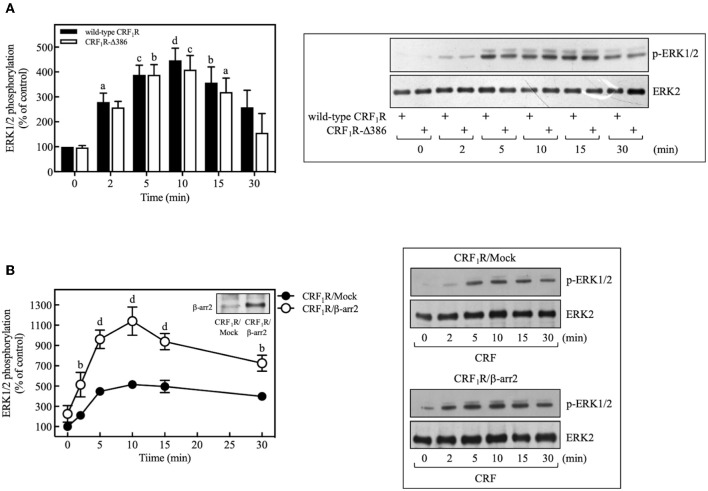
β-arrestin does not participate in the CRF-stimulated ERK 1/2 phosphorylation in COS-7 cells. (A) COS-7 cells expressing HA-CRF1R (wild-type CRF1R) or HA-CRF1R-Δ386 mutant were stimulated with 100 nM CRF for the indicated times. (B) COS-7 cells co-transfected with a β-arrestin-2 (β-arr2) expression vector or an empty control vector (Mock) and the pcDNA3-HA-CRF1R expression vector were stimulated with 100 nM CRF for the indicated times. Total cell lysates were separated by SDS-PAGE and analyzed by immunoblotting with anti-p-ERK1/2 Thr202/Tyr204, as described in Materials and Methods. ERK1/2 phosphorylation was quantitated by densitometry, and mean values were plotted from three to five independent experiments. Vertical lines represent the S.E.M. Western blots were also probed for total ERK showing equal loading. (A)
ap < 0.05, cp < 0.001, dp < 0.0001, bp < 0.01 vs. 0 min (CRF1R); bp < 0.01, cp < 0.001, ap < 0.05 vs. 0 min (CRF1R-Δ386). (B)
bp < 0.01 vs. CRF1R (2 or 30 min); dp < 0.0001 vs. CRF1R (5, 10, or 15 min).